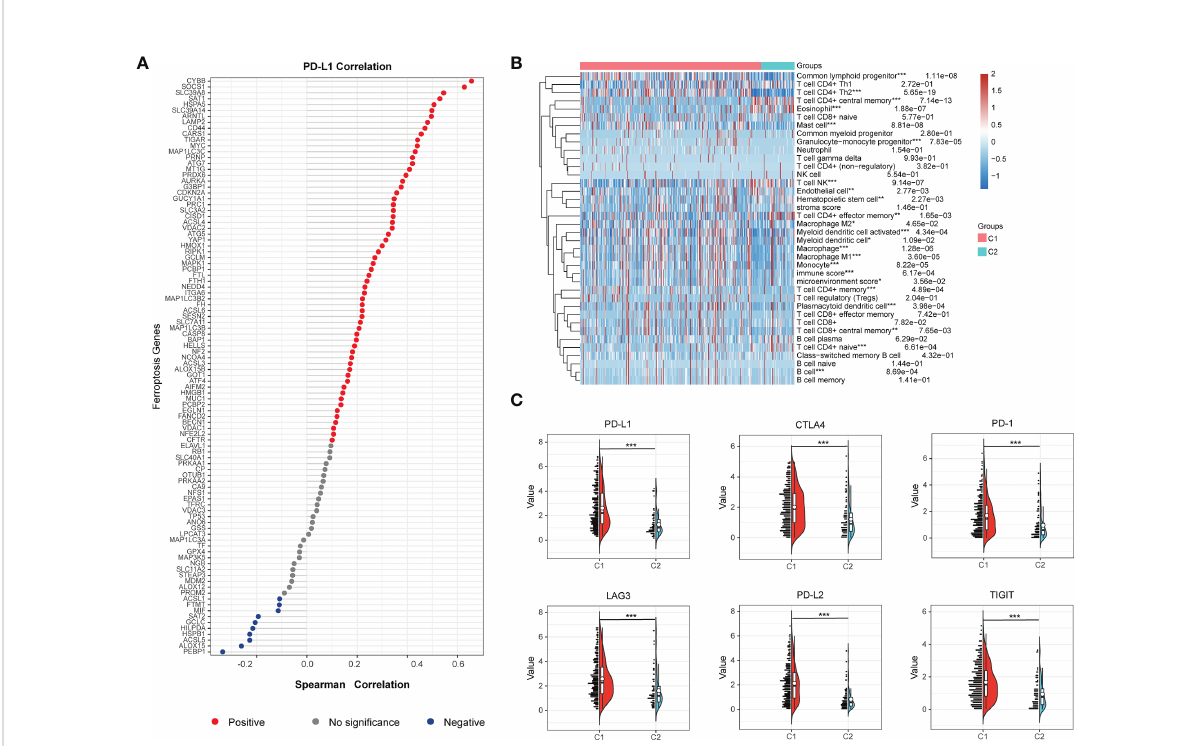
FIGURE 3 Distinct tumor immune microenvironment (TIME) between two BCa clusters. (A) Correlations of ferroptosis regulators with PD-L1 expression in BCa. The red dots represent positive correlation, grey dots represent no signi fi cance, and blue dots represent negative correlation. (B) The heatmap visualized distinct in fi ltrating level of immune cells between two BCa clusters. (C) The half-violin plots visualized the distribution of the immune checkpoints of two BCa clusters. *p < 0.05; **p < 0.01, ***p <